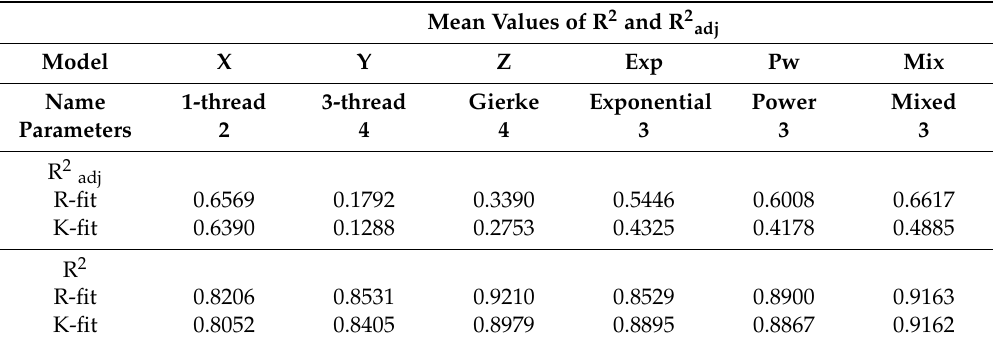
Table 9. Results of fitting the six membrane models using all datasets.